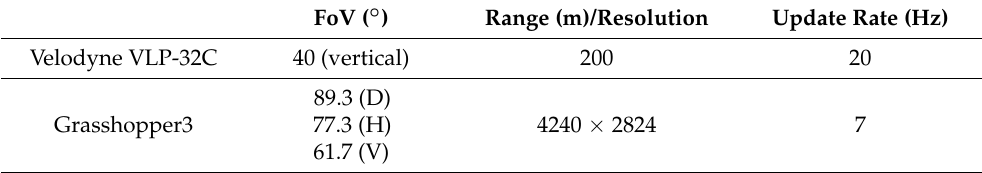
Table 1. Specifications of the primary camera and LiDAR sensors of the iseAuto shuttle.